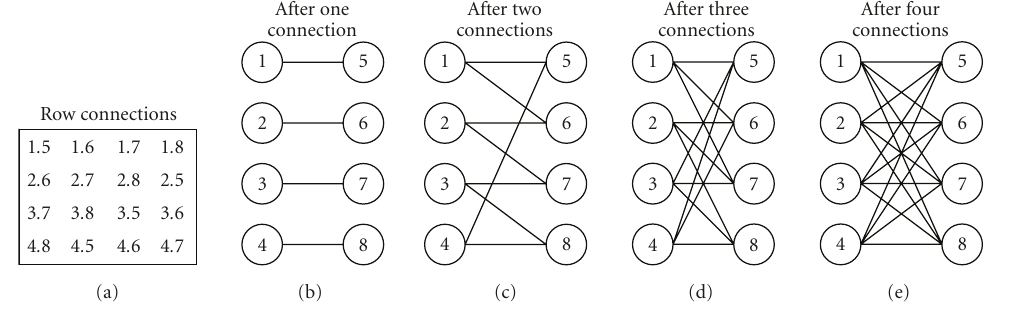
Figure 2: Graph representation of a (16, 2, 4) code with girth eight.